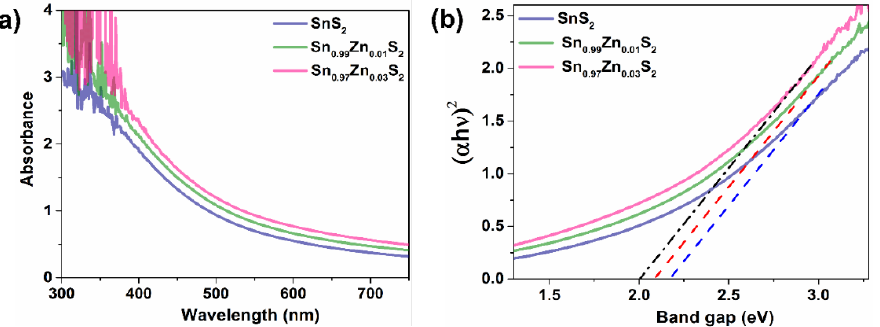
Figure 6. Properties of SnS 2 , Sn 0.99 Zn 0.01 S 2 and Sn 0.97 Zn 0.03 S 2 nanoflakes. ( a ) UV−vis absorption spectrum of the SnS 2 , Sn 0.99 Zn 0.01 S 2 and Sn 0.97 Zn 0.03 S 2 nanoflakes. ( b ) Tauc’s plot extracted from the absorption spectrum revealing their direct band gap.